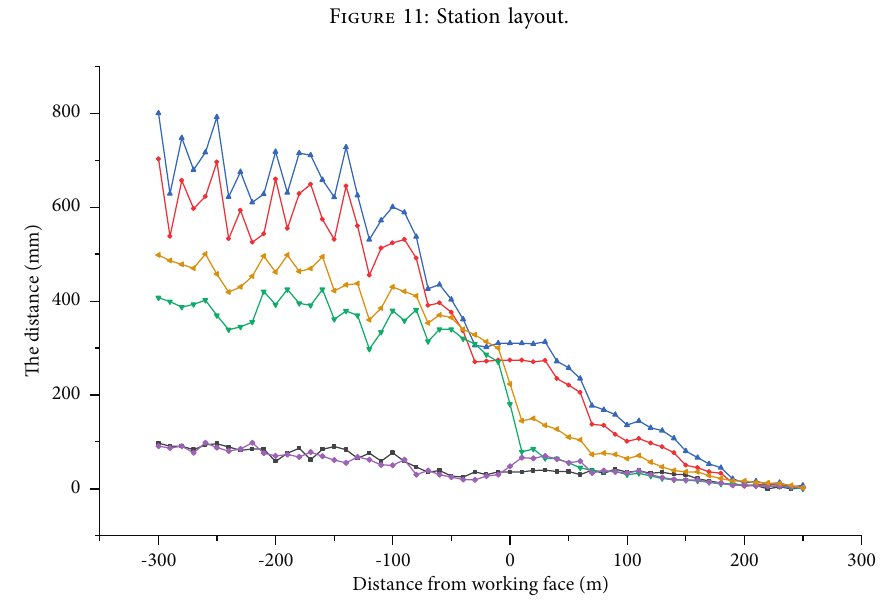
Figure 11: Station layout.